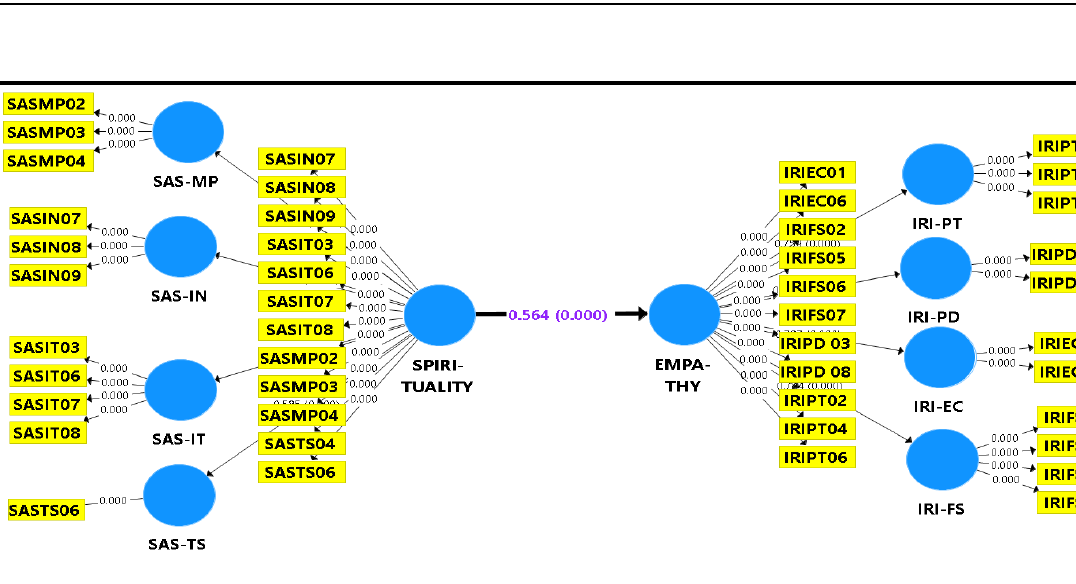
Figure 2. Spirituality Affects Empathy